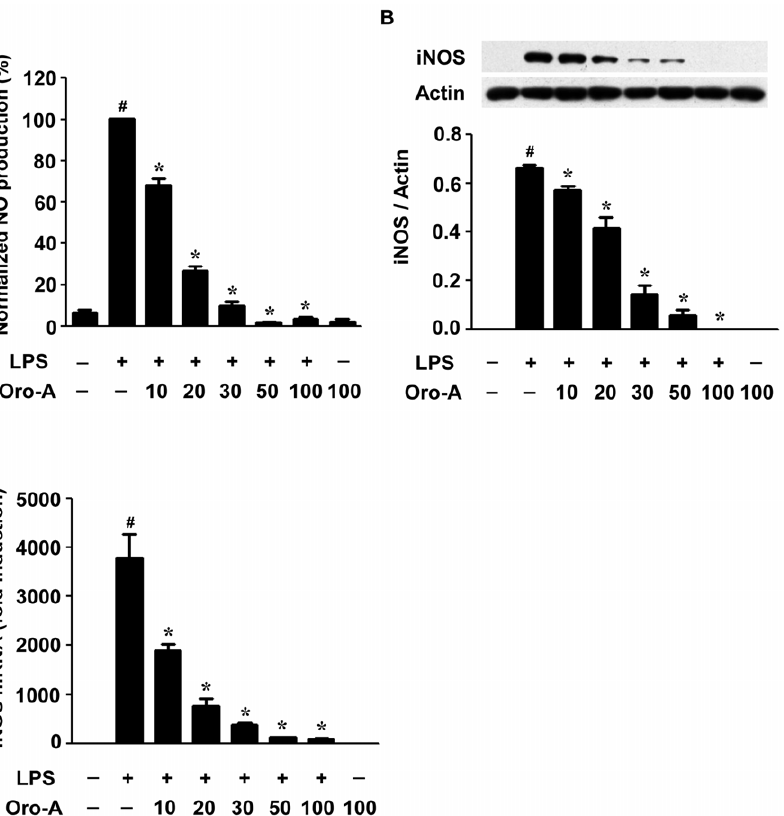
Figure 1. Oroxylin A attenuation of LPS-induced NO production and iNOS expression in BV-2 cells. ( A ) BV-2 cells were cultured in a 24- well plate at 5 6 10 4 cells/well and were exposed to oroxylin A (Oro-A, 10–100 m M) and LPS (100 ng/ml) for 24 hours. The NO concentration in the medium was measured by Griess reaction. All results are normalized to LPS-treated control group and are means 6 SEM from three independent experiments in triplicates. ( B ) BV-2 cells (2 6 10 6 cells) cultured in a 10-cm Petri-dish were treated with LPS (100 ng/ml) and oroxylin A (10–100 m M). After 24 hours, cells were harvested and total proteins were subjected to Western blot analysis using specific antibodies against iNOS and actin. A representative Western blot for iNOS and actin is shown in upper panel. The ratios of iNOS to actin are shown in bottom panel. Results are means 6 SEM from three independent experiments. ( C ) BV-2 cells (5 6 10 4 cells/well) were incubated with LPS (100 ng/ml) and oroxylin A (10–100 m M) for 20 hours. Total mRNA was then isolated and converted to cDNA, followed by quantification of iNOS mRNA levels by real-time PCR. Levels of iNOS mRNA are normalized to that of actin mRNA. Results are expressed as fold induction relative to vehicle-treated cells, and are mean 6 SEM from three independent experiments. # , p , 0.05, one-way ANOVA followed by Tukey’s post hoc test compared with vehicle-treated cells. * , p , 0.05, one-way ANOVA followed by Tukey’s post hoc test compared with LPS-treated cells.